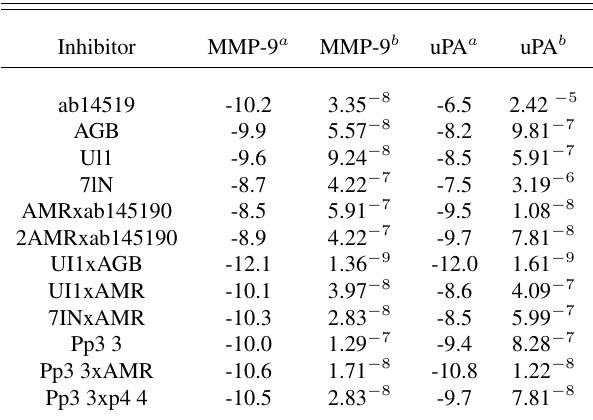
Table 1. Calculated affinity for proteins inhibitors complexes shown as kcal/mol or as K